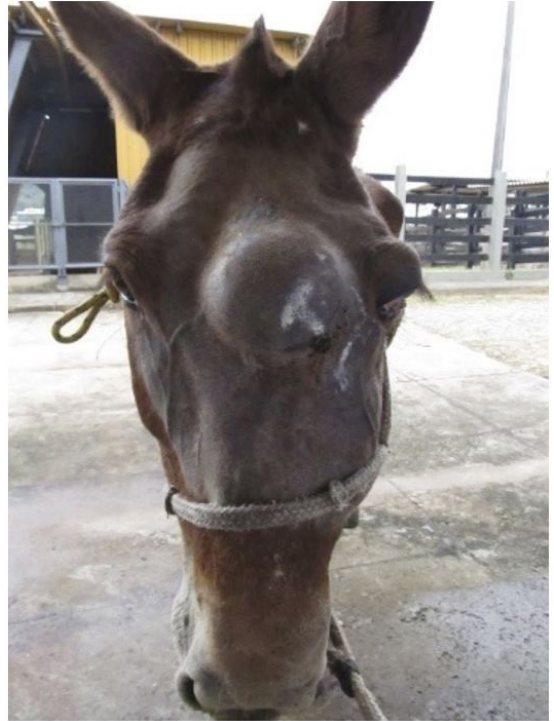
Figure 1. Clinical presentation of the facial region of a six-year-old donkey. Centrally, there is a nodular mass between the orbits, as well as facial asymmetry, with enlargement of the frontal and nasal bones, causing exophthalmos of the ipsilateral eye.